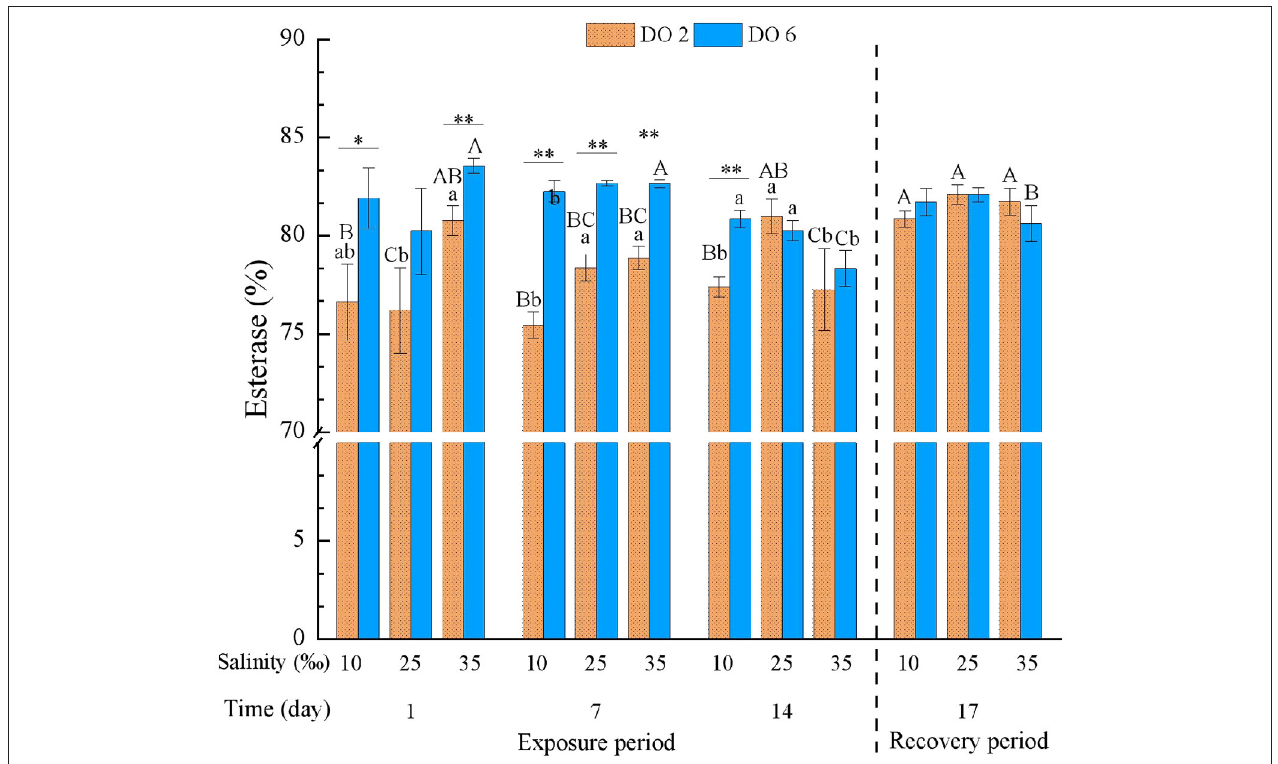
FIGURE 5 | Esterase (EST) of C. hongkongensis exposed to six combinations of salinity (10, 25, and 35 ‰ ) and DO (2 and 6 mg/L) at 1, 7, and 14 days during the exposure period and 3 days for the recovery period. Different capital letters indicate significant differences among time points within each salinity level in hypoxia level (2 mg/L) or control group (6 mg/L) ( p < 0.05). Different small letters indicate significant differences between salinity within each time point in salinity level in hypoxia level (2 mg/L) or control group (6 mg/L) ( p < 0.05). Asterisk indicates significant differences between DO within each time point and fixed salinity treatment, in which * represents significant difference ( p < 0.05) and ** represents highly significant difference ( p <